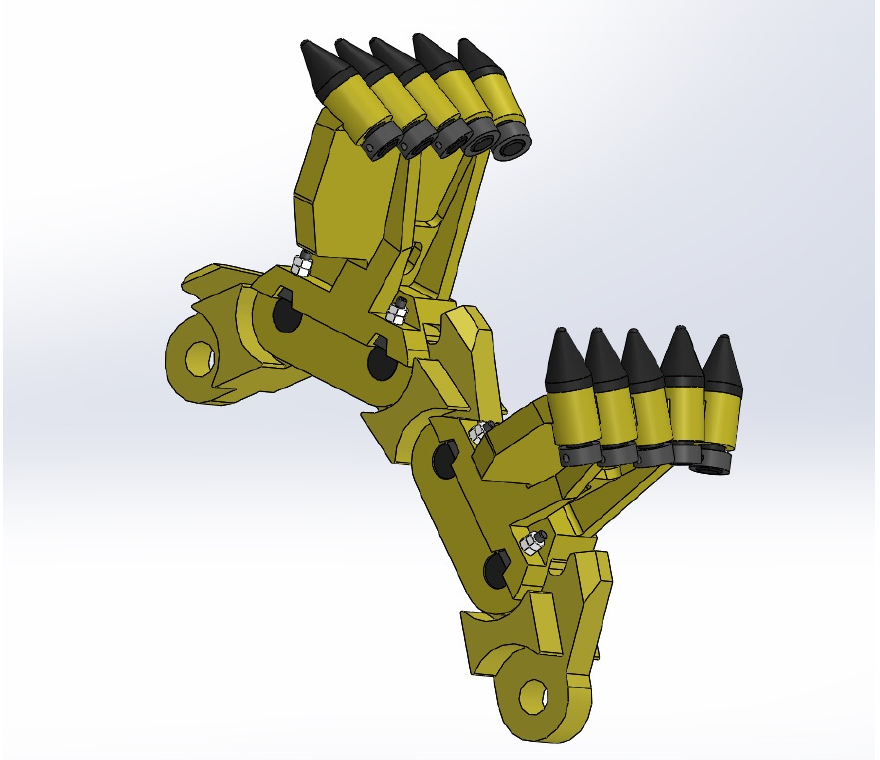
Figure 3. CAD representation of the excavating chain segments, designed in SolidWorks 2018. Table 1. Sample enumeration.